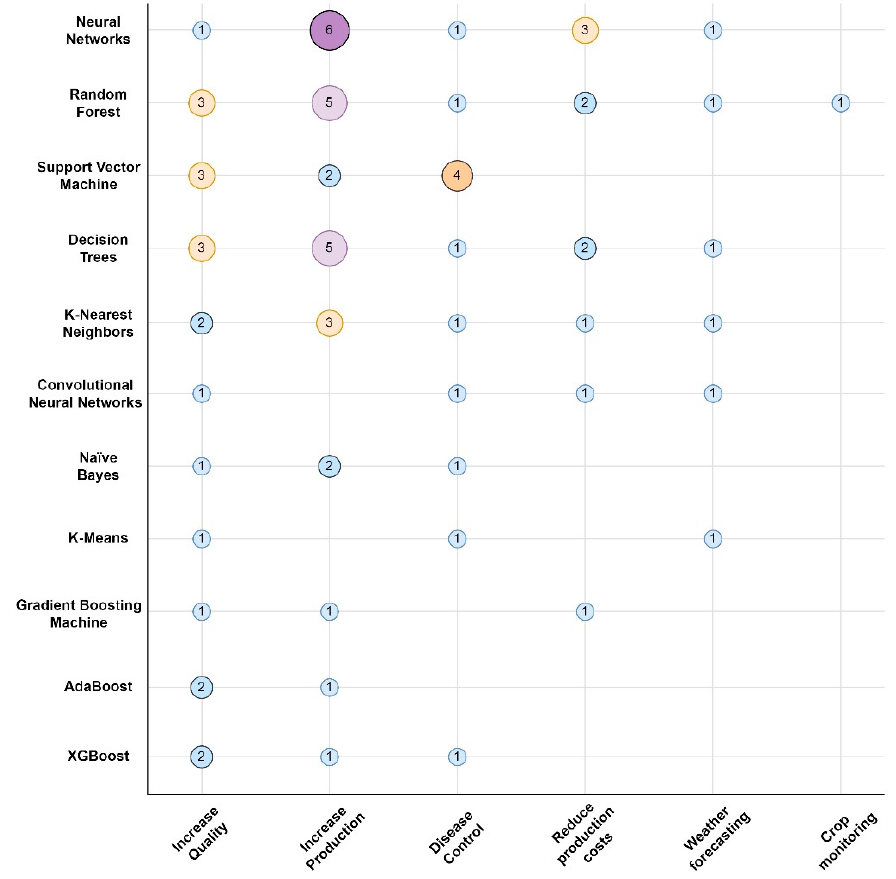
Figure 13. ML Main problems to be solved vs. ML techniques.